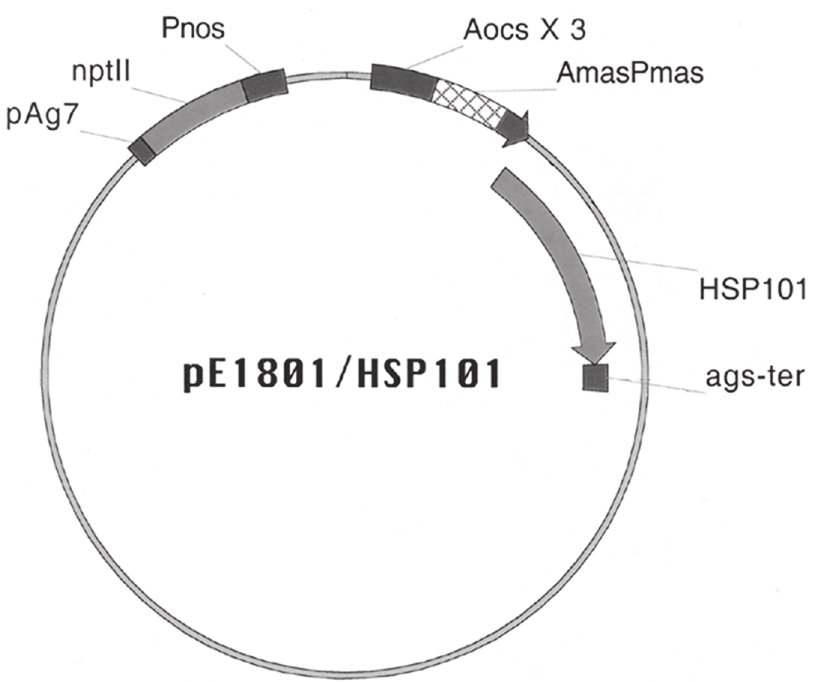
Fig 1. Diagram of pE1801-ocs/mas ‘ superpromoter ’ -HSP101 plasmid. PAg7 = Transcription termination and poly-Adenylation signal sequence from Octopine Ti-Plasmid T-DNA (gene for transcript #7) [57]; NptII = Neomycin phosphotransferase II coding region [58]; Pnos = Nopaline synthase promoter from Nopaline Ti- Plasmid T-DNA [59]; Aocs X 3 = Octopine synthase enhancer element (3 copies) from Octopine T-Plasmid T-DNA [60]; AmasPmas = Manopine synthase promoter from Octopine Ti-Plasmid T-DNA [61]; HSP101 = Heat shock protein (101 kdalton molecular weight) from A . thaliana [32]; Ags-ter = Transcription termination and poly-Adenylation signal sequence from Octopine Ti-Plasmid T-DNA (Agropine synthase gene) [62].